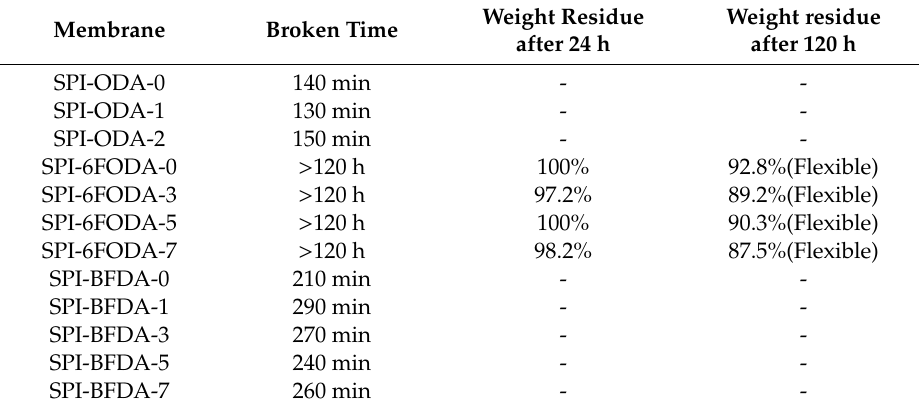
Table 4. Hydrolytic stability of sulfonated polyimide membranes.